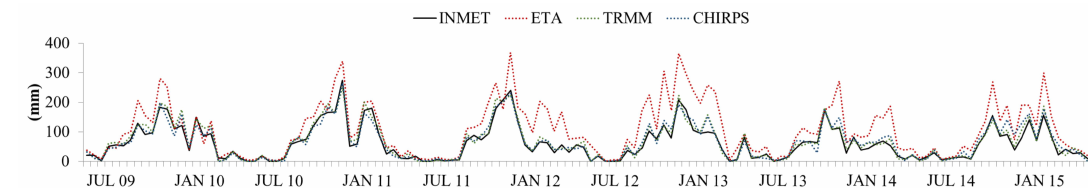
Figure 2. Distribution of the average accumulated precipitation estimated from Eta, TRMM, and CHIRPS and observed at fourteen INMET meteorological stations between July 2009 to June 2015, for the south-southeast region of Minas,